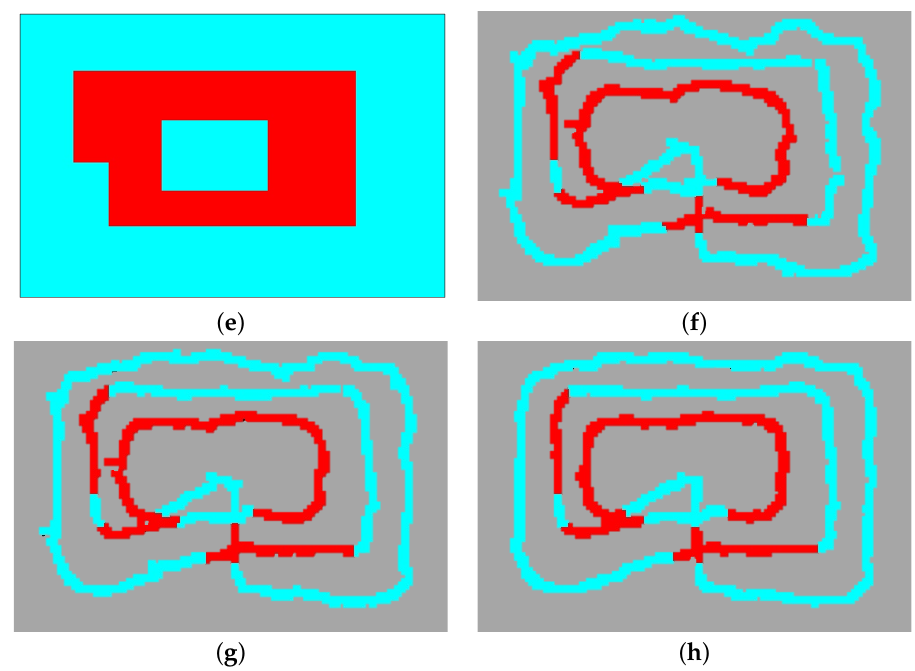
Figure 9. The ground truth and estimated maps. In the ground resistance map and road grade map plotted by EKF with 1 IMU and 1 GPS, the spikes caused by infrequent GPS are quite obvious. With an additional GPS sensor fused in Kalman filter, the spikes improve a lot. ( a ) Predefined five areas of resistance plotted by OpenCV; ( b ) Result of ground resistance map with wheel loader (EKF with 1 IMU and 1 GPS); ( c ) Result of ground resistance map with wheel loader (UKF with 1 IMU and 1 GPS); ( d ) Result of ground resistance map with wheel loader (UKF with 1 IMU and 2 GPS); ( e ) Predefined two areas of road grade plotted by OpenCV; ( f ) Result of road grade map with wheel loader (EKF with 1 IMU and 1 GPS); ( g ) Result of road grade map with wheel loader (UKF with 1 IMU and 1 GPS); ( h ) Result of road grade map with wheel loader (UKF with 1 IMU and 2 GPS).